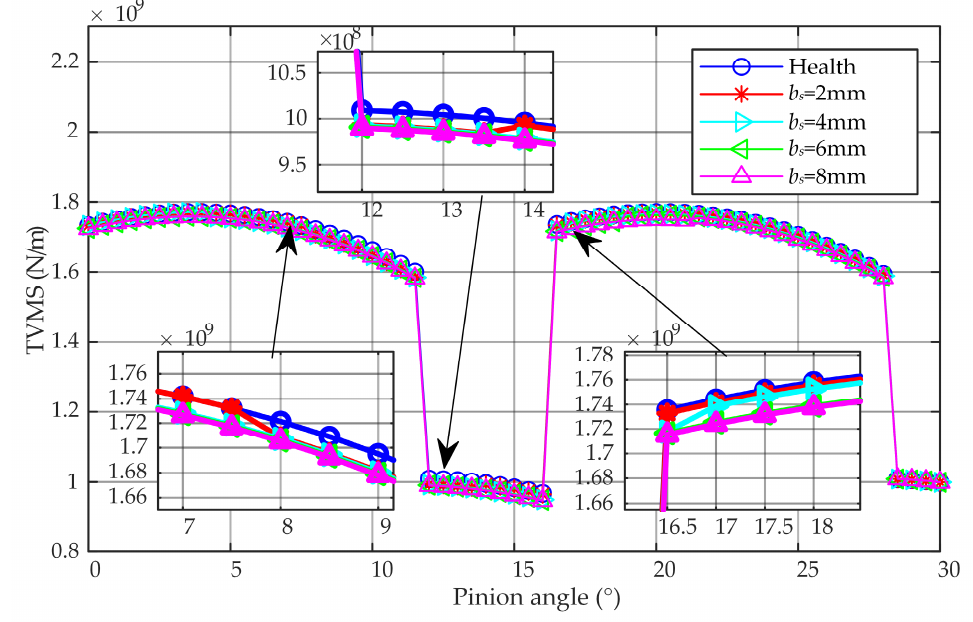
Figure 5. Comparison of TVMS of gears with different spalling widths under fixed lengths and depths. Figure 6 shows the comparison of TVMS at different spalling depths with a spalling length of 10 mm and a spalling width of 4 mm. Similar to the effect of spalling length, the spalling depth decreases the overall meshing stiffness at the gear fault location. Compared to the spalling length, the spalling depth does not affect the change in the Hertzian stiffness, so its impact effect is smaller. Thus, it can be seen that the most significant impact on the peak value of the loss of TVMS is the spalling length, while the largest impact on the loss range of the TVMS is the spalling